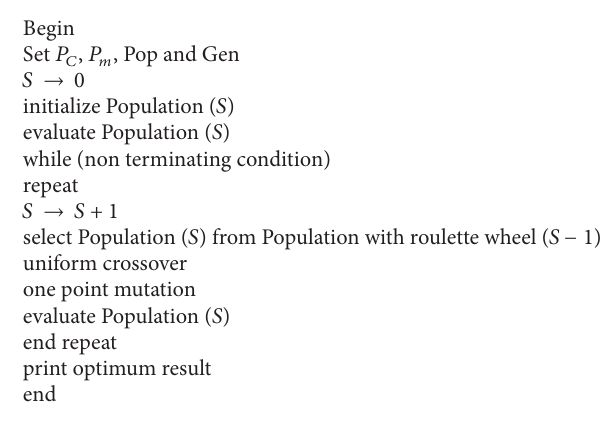
Pseudocode 2: The pseudocode of MOGA